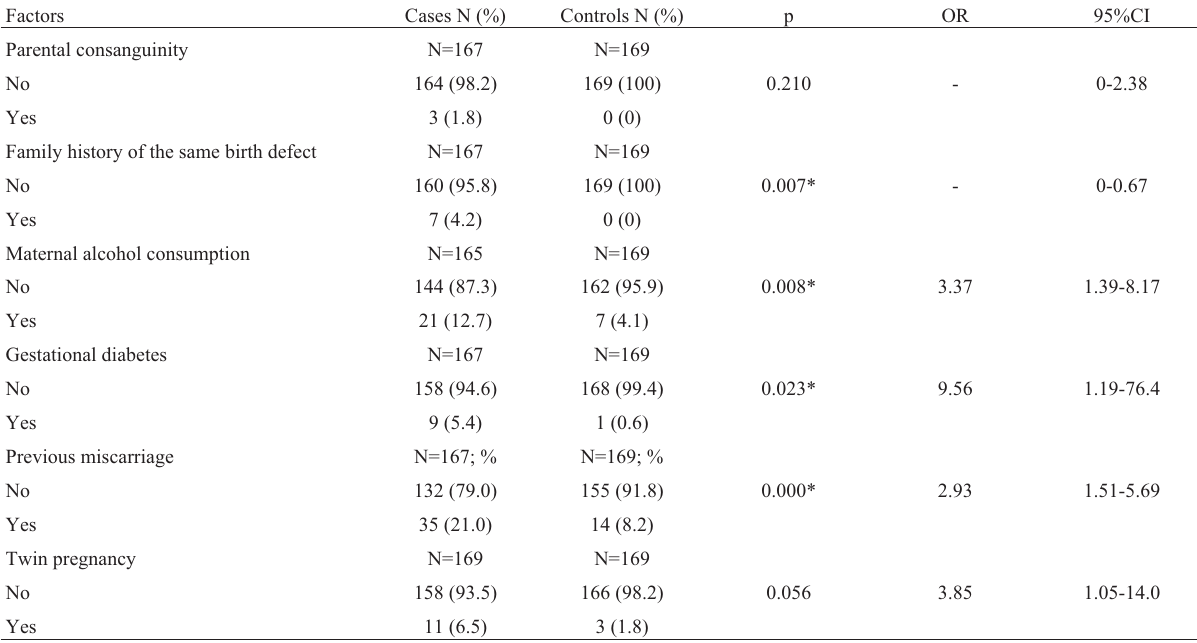
Table 3 - Characteristics of subjects and their relationship with birth